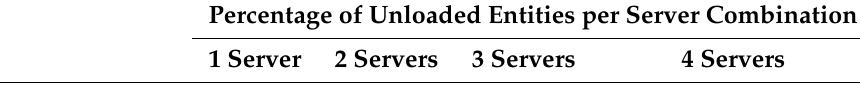
Table 4. Proportion of entities unloaded while different numbers of servers were